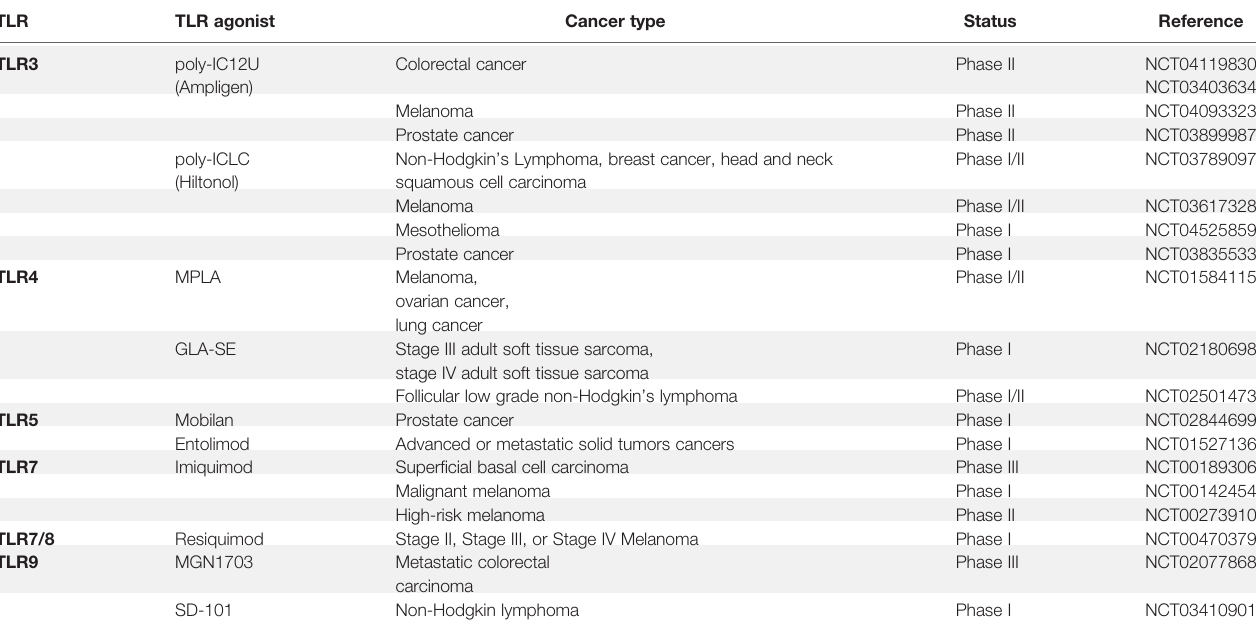
TABLE 2 | Clinical trials of TLR agonists TLR in